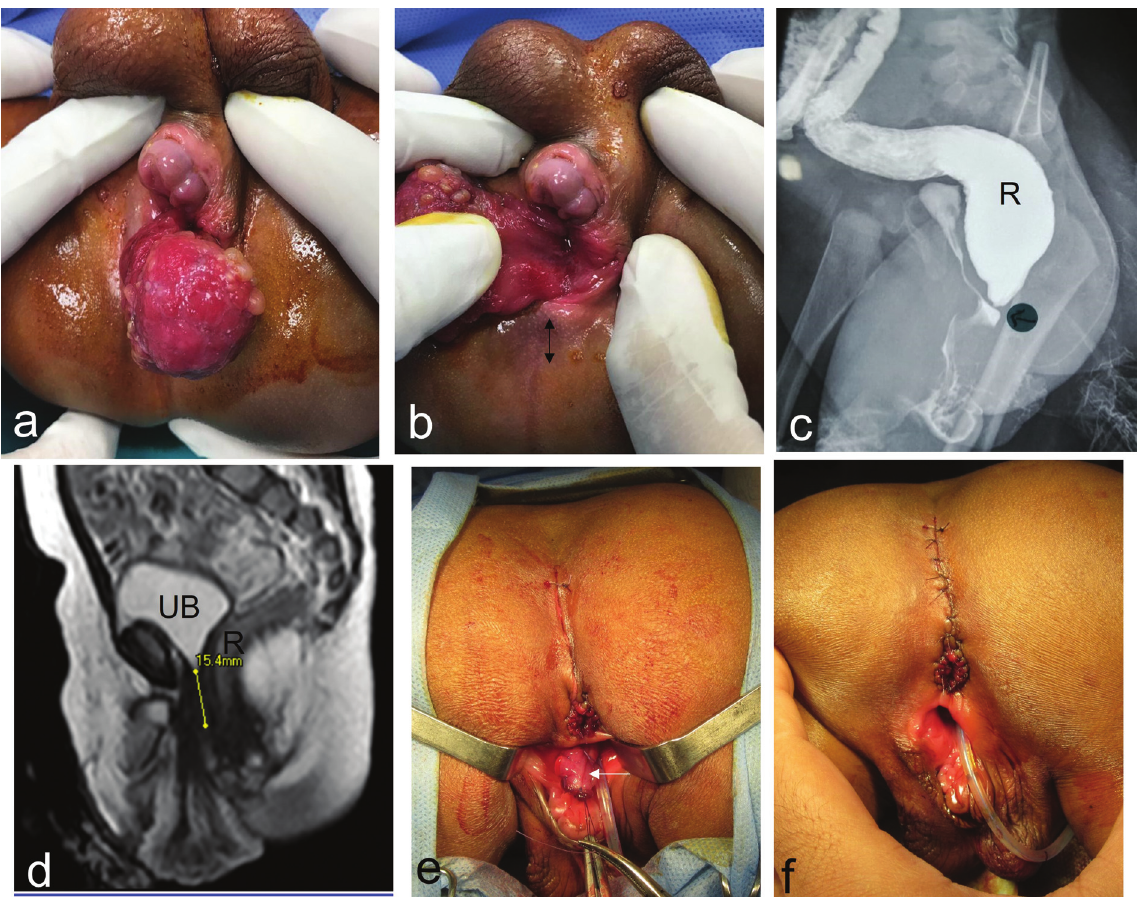
Fig. 2 The second case: ( A, B ) Clinical examination of the perineum demonstrates the caudally displaced hypospadiac phallus and perineal swelling. Note: The presence of a single “ central ” perineal ori fi ce anterior to the predestined site of the normal anus (double arrowhead line). ( C ) Contrast X-ray study: injection of contrast through distal colostomy demonstrating the rectum (R) communicating with the urethra to form a common perineal exit. ( D ) Mid sagittal T2-weighted imaging (pelvic magnetic resonance imaging) demonstrating the urinary bladder (UB) and rectum (R). Note the funneling and descent of the bladder neck in the pelvis down to the level of the lower end of pubic symphysis; also, the measured distance at which the rectum joins with the urethra is approximately 15mm below the bladder neck. ( E, F ) Operative photos for posterior sagittal anorectoplasty and excision of perineal swelling (white arrow is pointing to stump after excision of perineal